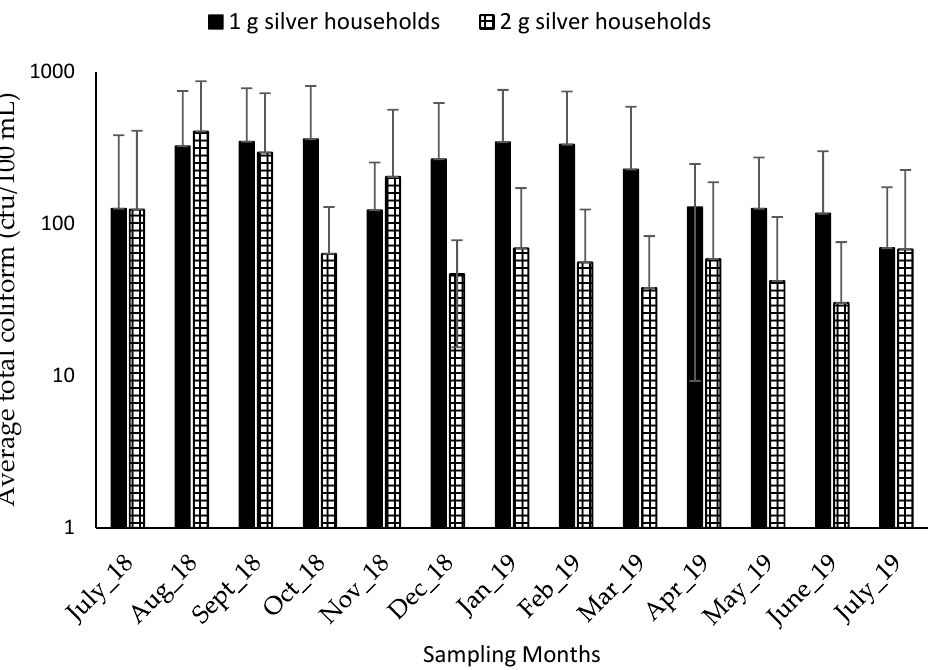
Figure 3. Average values of total coliform of raw water (n = 390).